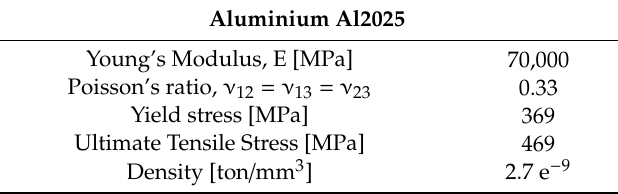
Table 4. Aluminium Al 2024 mechanical